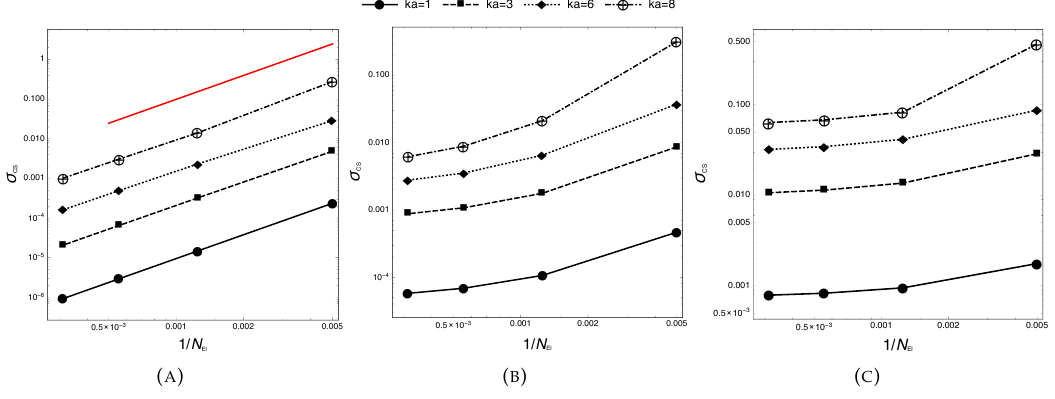
Figure 5. Convergence of σ cs with the number of field elements in Ω c , N el , for four values of ka . Equation (5). Mach number M b = 0.0,0.1,0.2 ( A , B , and C , respectively). The red line indicates the h 2 rate.